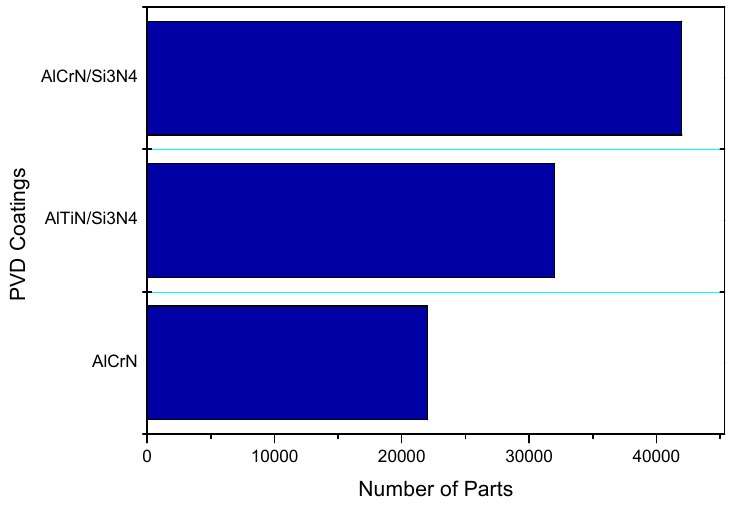
Figure 9. Number of parts produced by high pressure die casting (HPDC) until quality insufficient be achieved.